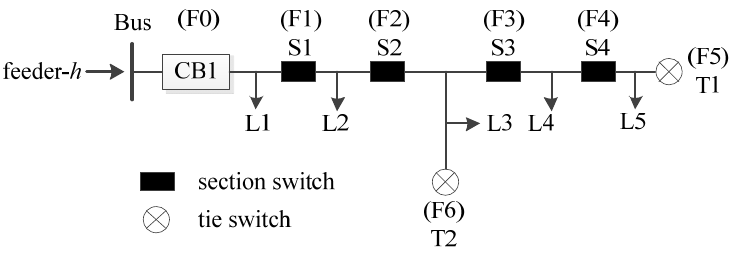
Figure 3. Multi-sectioned and multi-linked network of a distribution